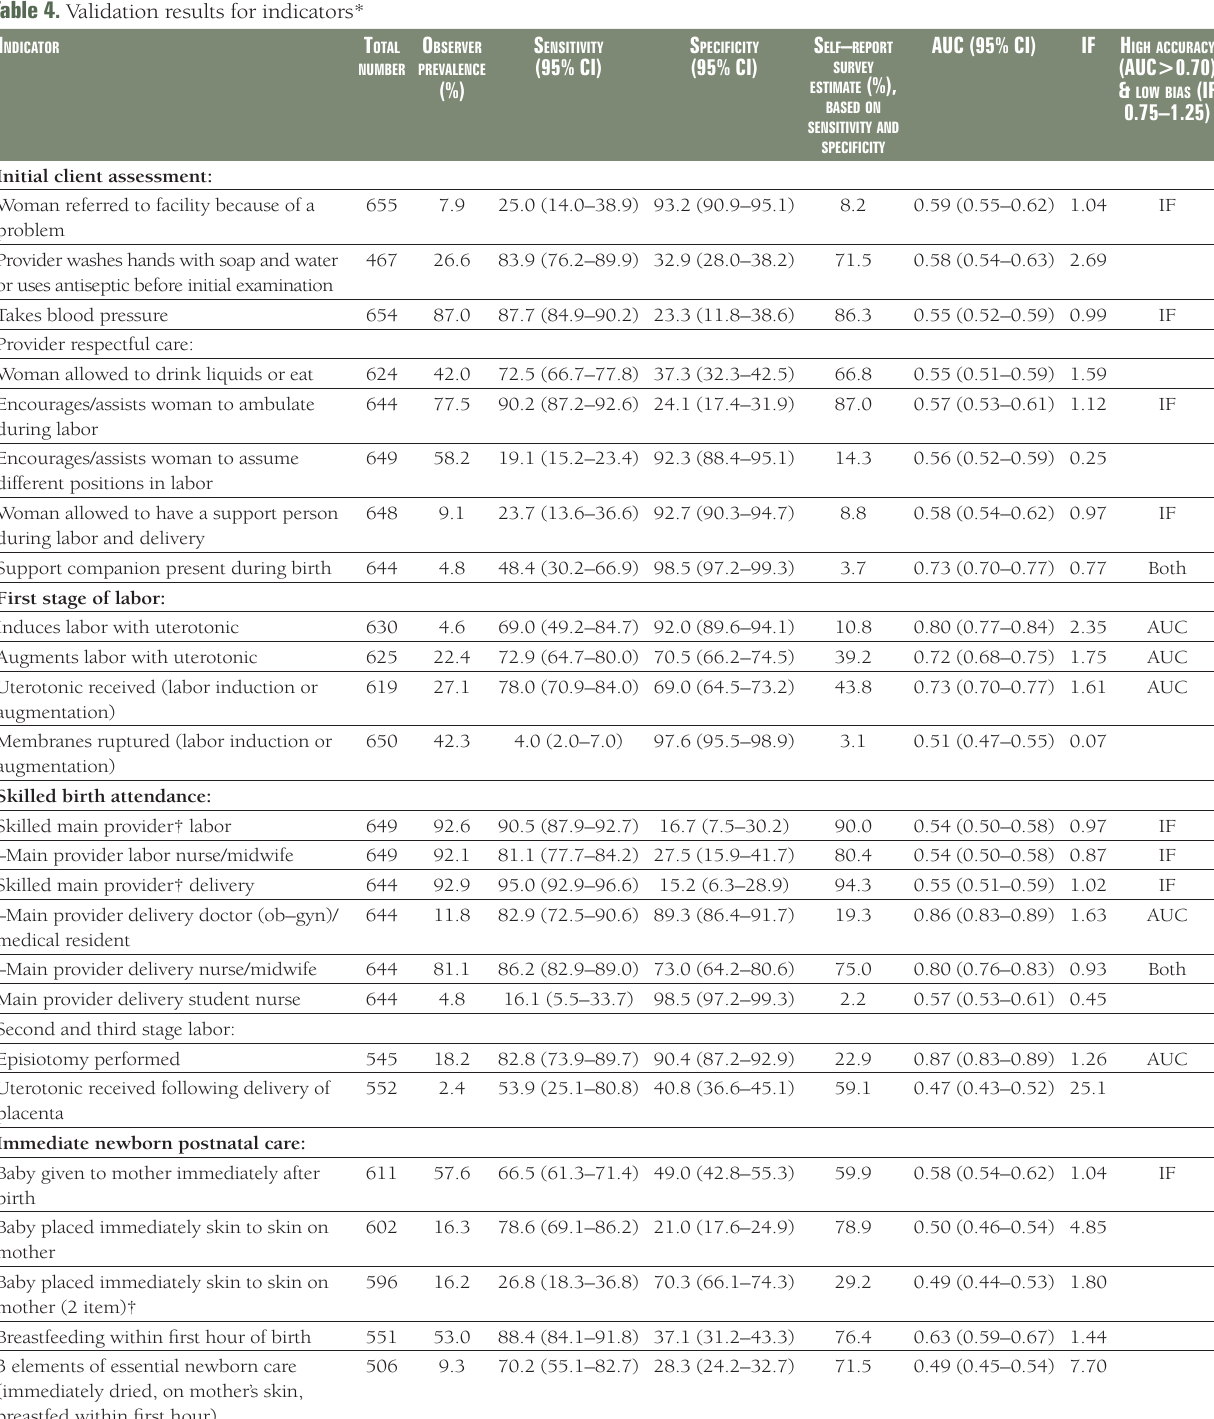
Table 4. Validation results for